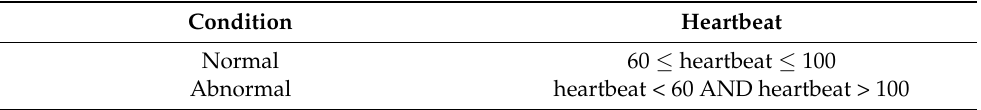
Table 2. The proposed system threshold ratings.